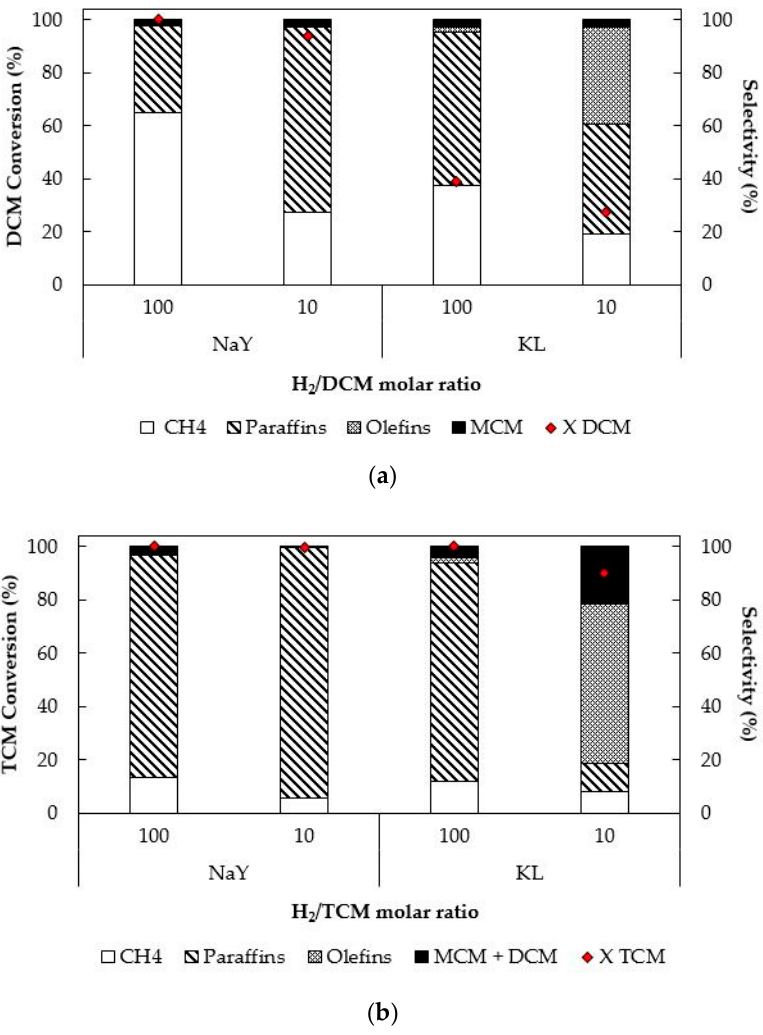
Figure 9. Conversion and selectivity distribution in the HDC of ( a ) DCM and ( b ) TCM with NaY and KY catalysts at H 2 :CM ratios of 10 and 100 (reaction temperature = 300 °C, τ = 0.8 kg h mol − 1 ).